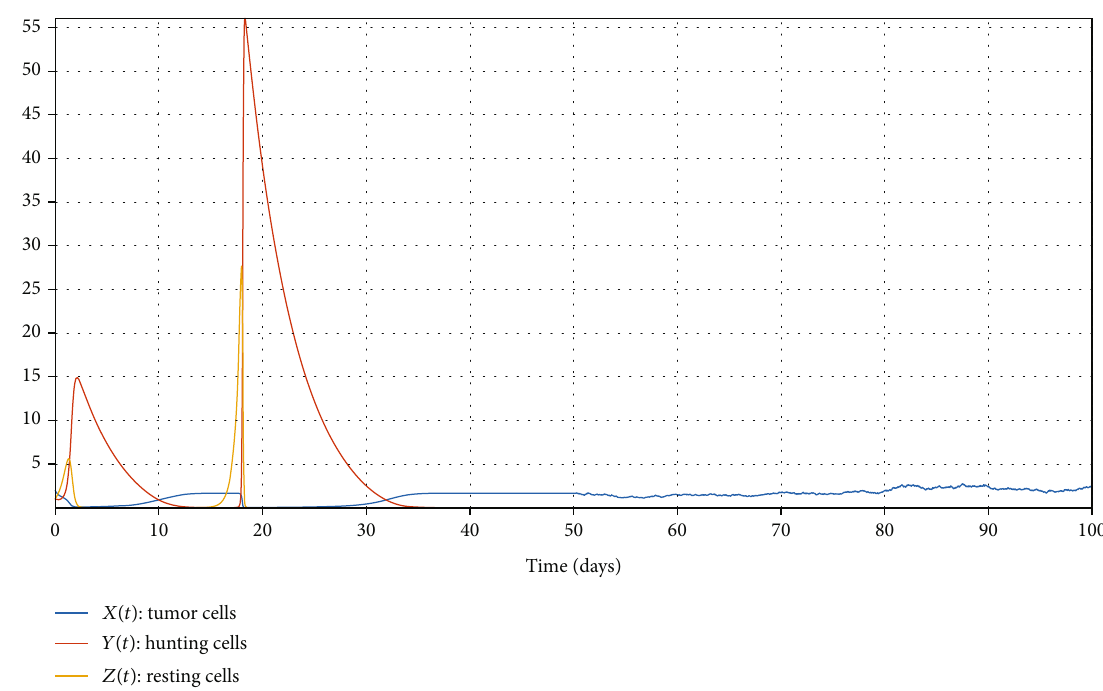
= 0 : 9 , c = 0 : 65 , c = 0 : 21 , c = 0 : 55 , c = 0 , c = 0 : 39 , c = 0 1 2 3 4 5 6 7